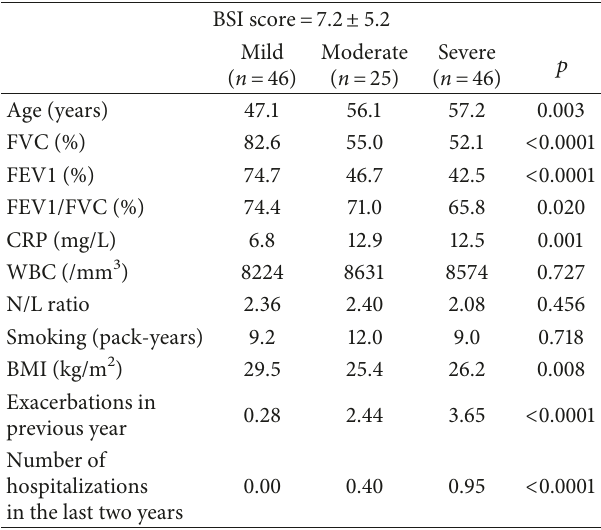
Table 2: The relation between bronchiectasis severity based on BSI score and the other study variables.